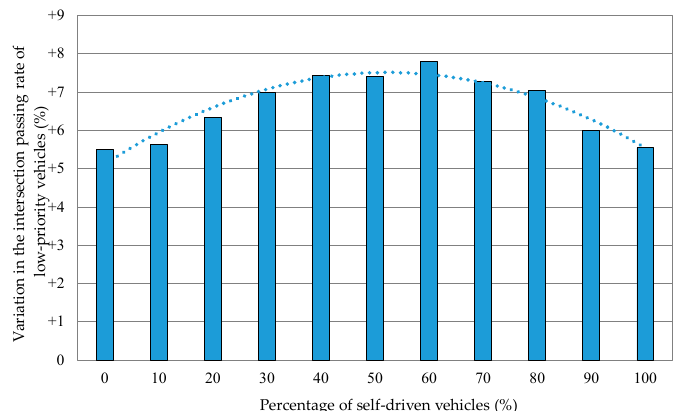
Figure 11. Variation in the intersection passing rate of low-priority vehicles when the percentage of self-driven vehicles was varied. The intersection passing rate was the average for all the vehicles that came in.